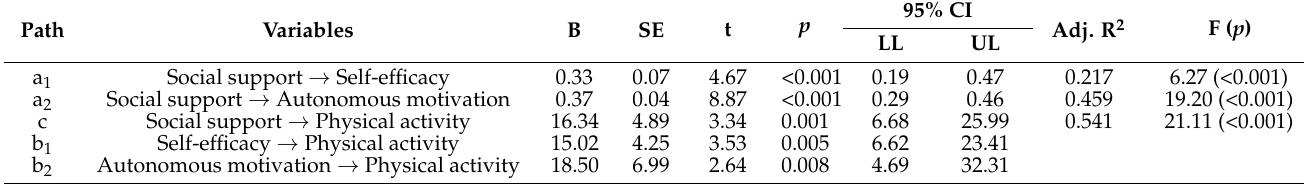
Table 3. Mediating effect of self-efficacy and autonomous motivation in the relationship between social support and physical activity (N =